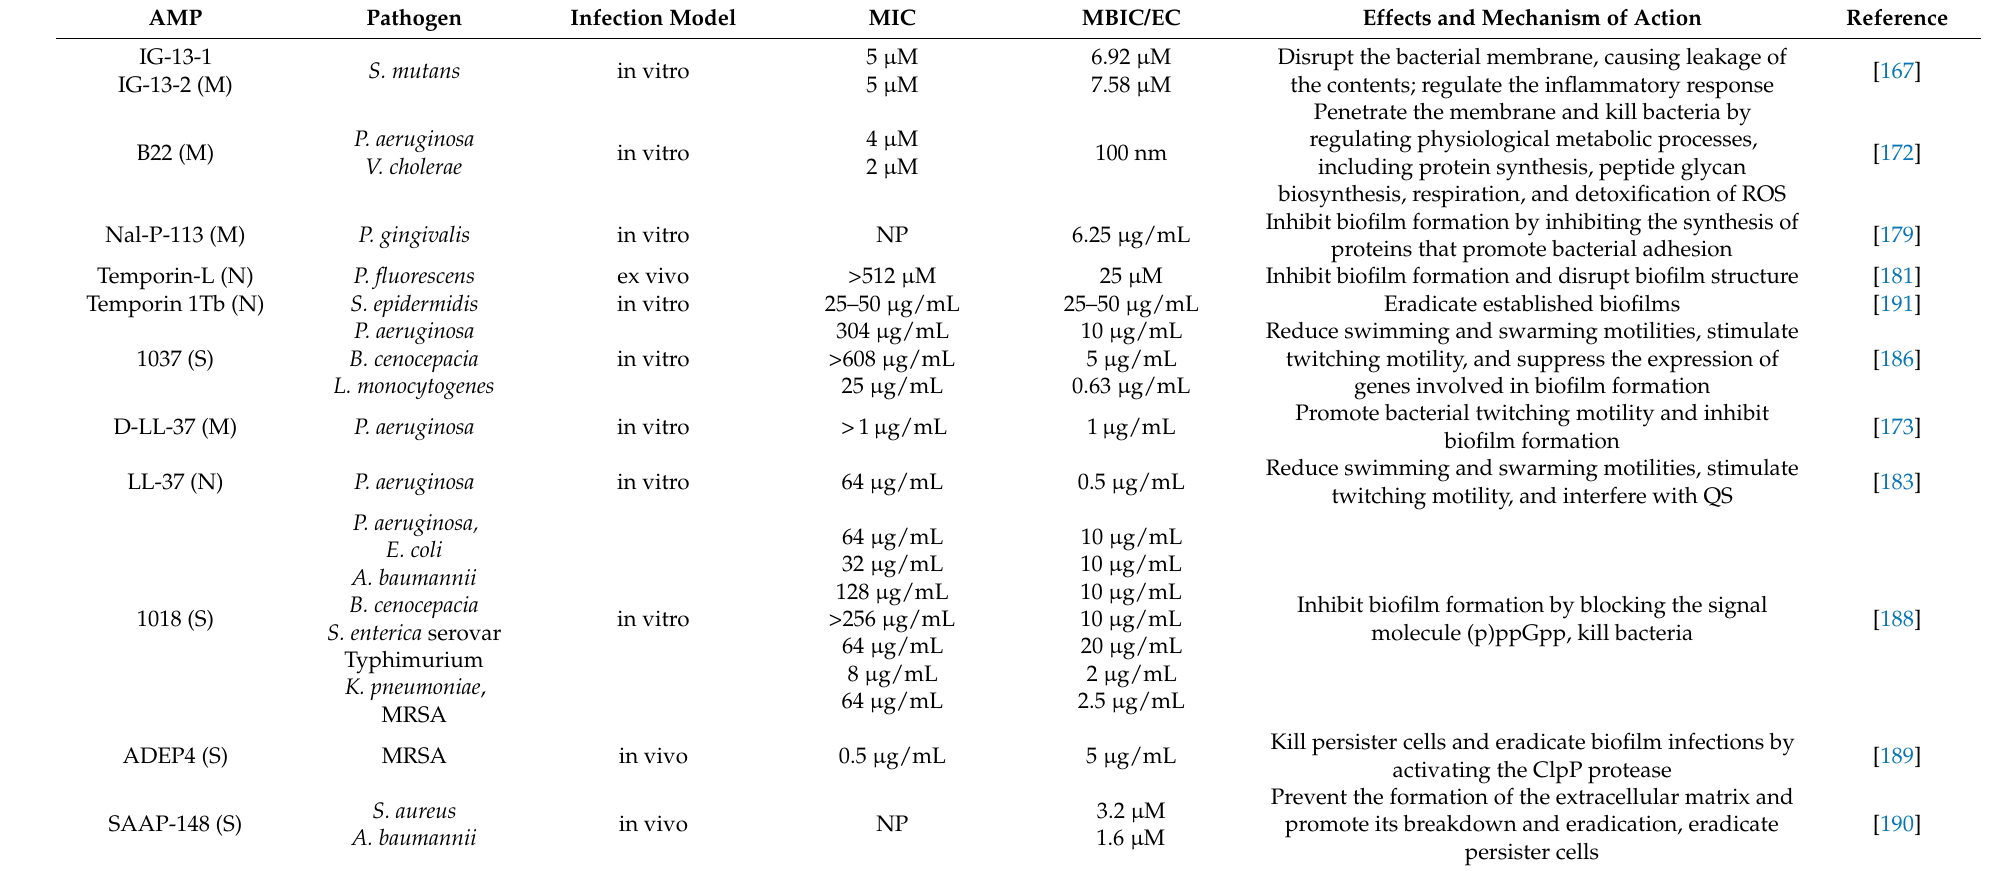
Table 3. Representative AMPs and their antibiofilm effects and mechanisms of